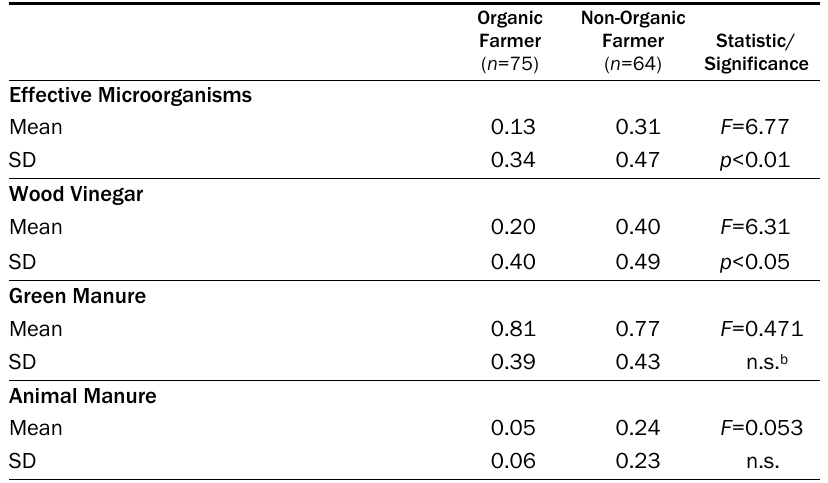
Table 10. Differences in Organic Production Methods a